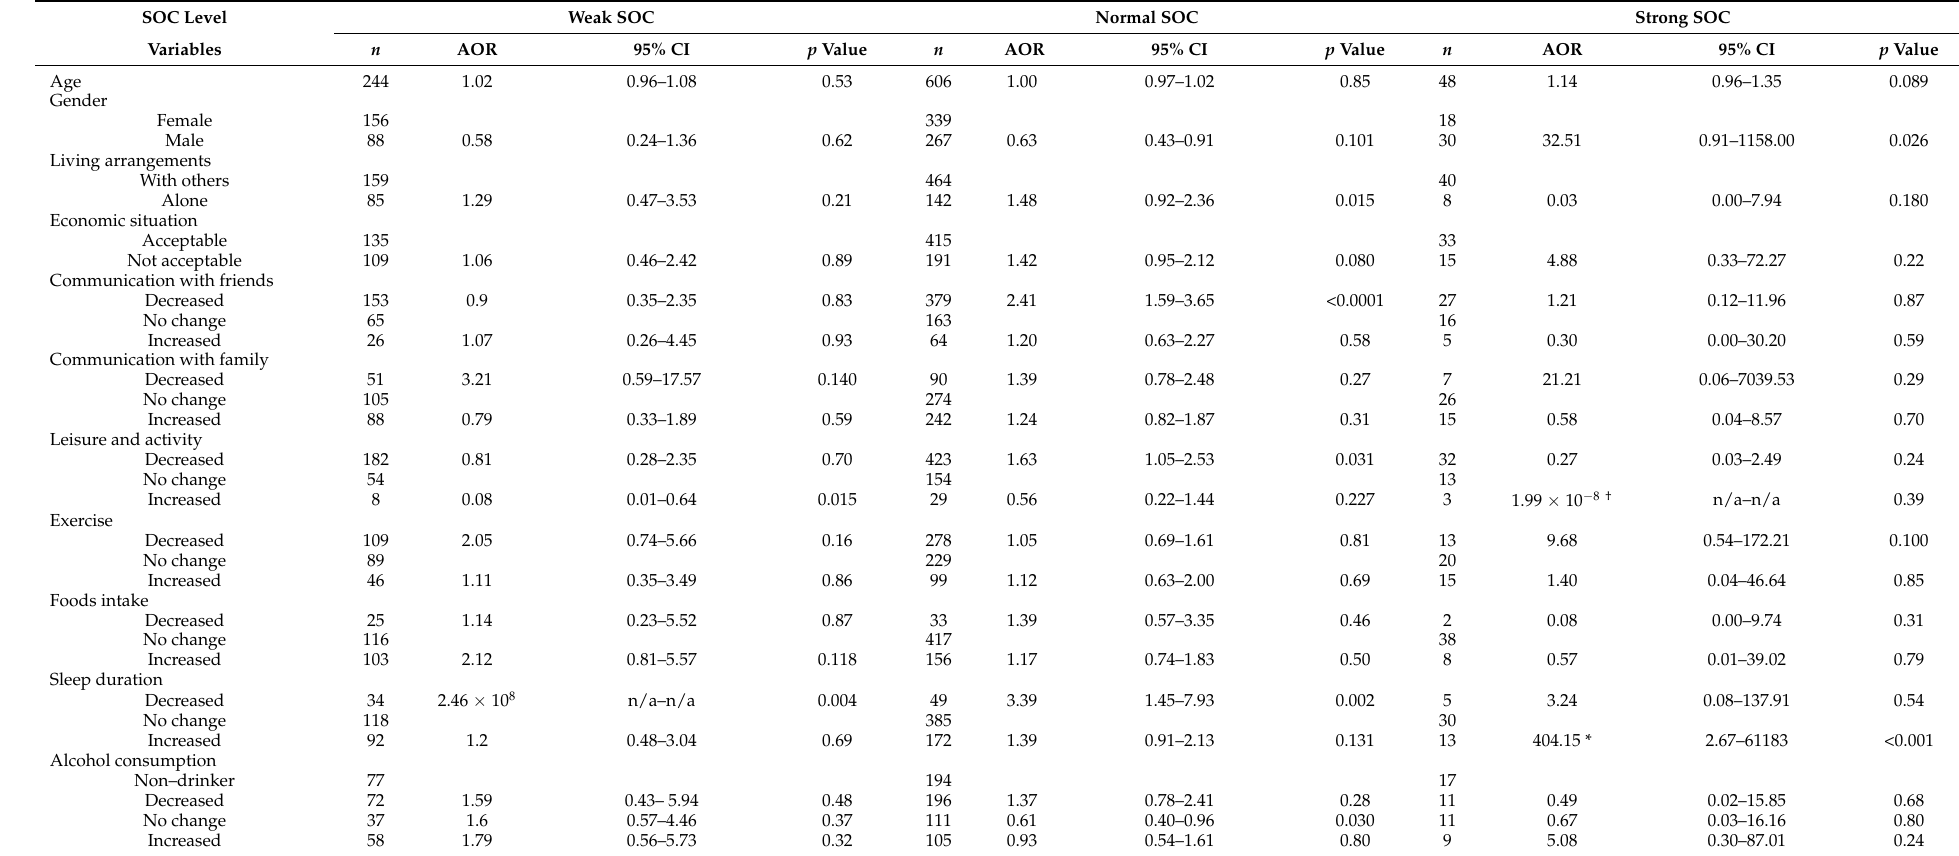
Table 4. Logistic regression analysis of the categories associated with poor mental health (GHQ-12), stratified by SOC